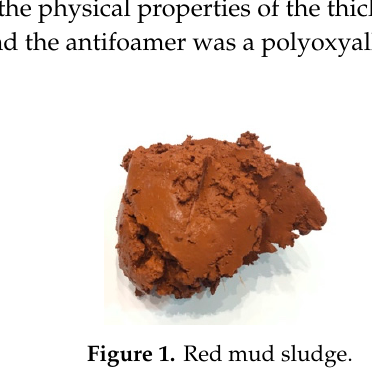
Table 2. Physical properties of thickener and antifoamer.